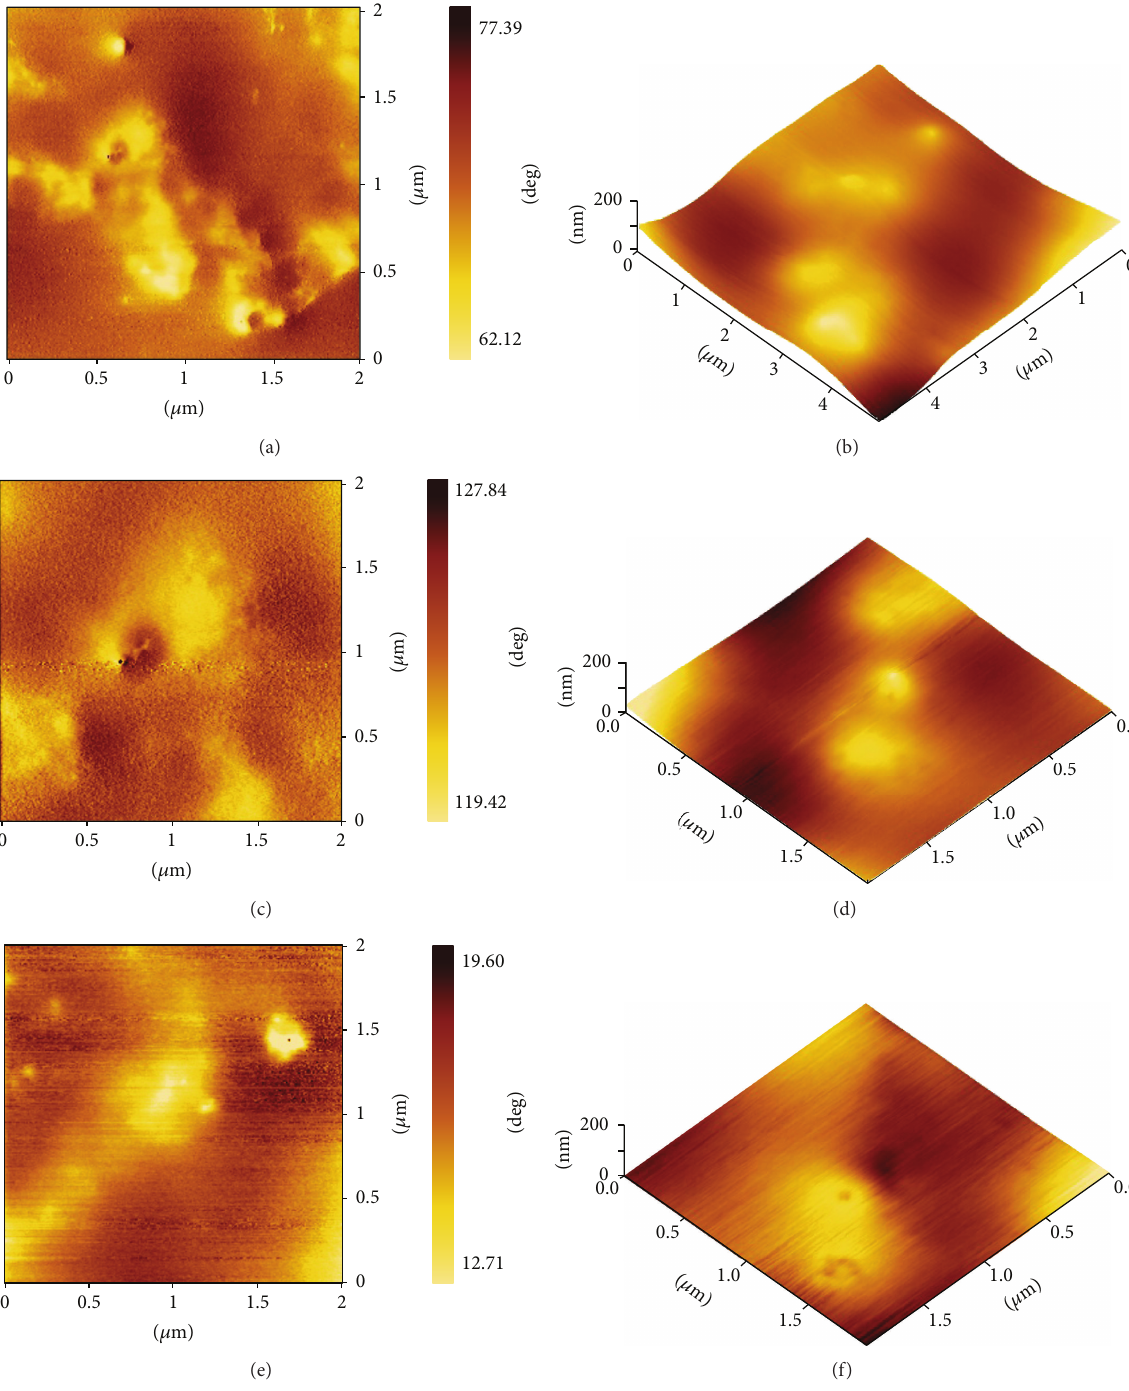
Figure14:AFMmicrographsoftheP3HT- b -P(S- co -CMS)preparedbyvariousATRPsystems;normalATRP(toprow),AGET-ATRP(middle row), and SR&NI ATRP (bottom row). The micrographs were recorded in a phase image tapping mode (left column) and a topographic mode (right